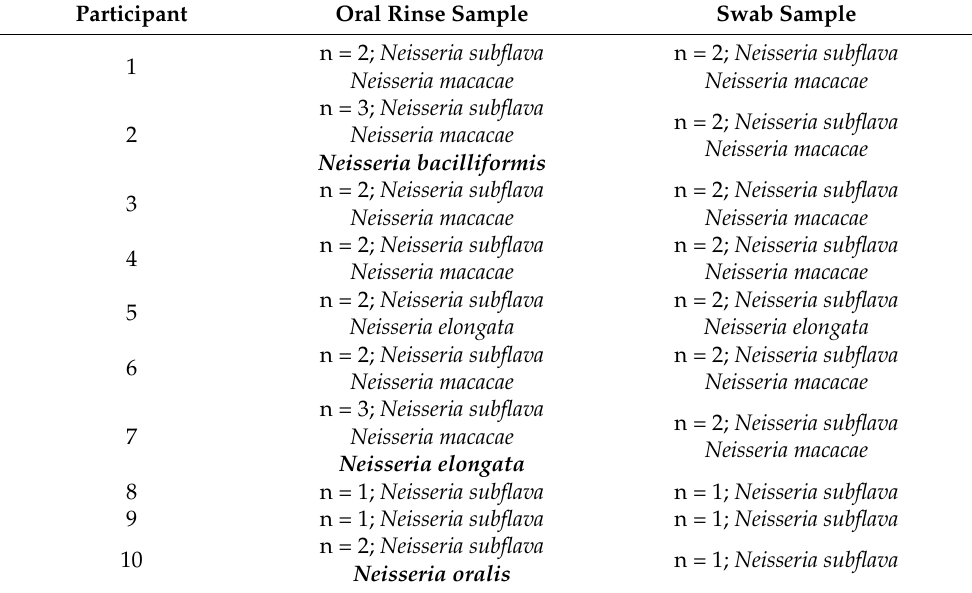
Table 1. Different Neisseria species isolated ( n ) from paired oral rinse and oropharyngeal swab samples present on the azithromycin-containing plate (2 µ g/mL) and the plate without